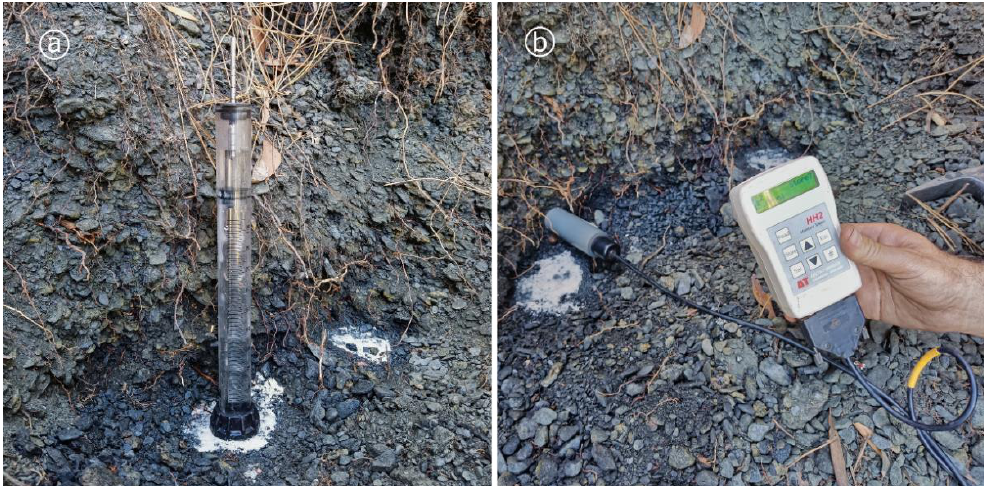
Figure 4. Field measurements of soil unsaturated hydraulic conductivity ( a ) and volumetric water content ( b ). Table 6. Soil unsaturated hydraulic conductivity and volumetric water content of soil horizons from S ã o Pedro da Cova mine waste pile. Test